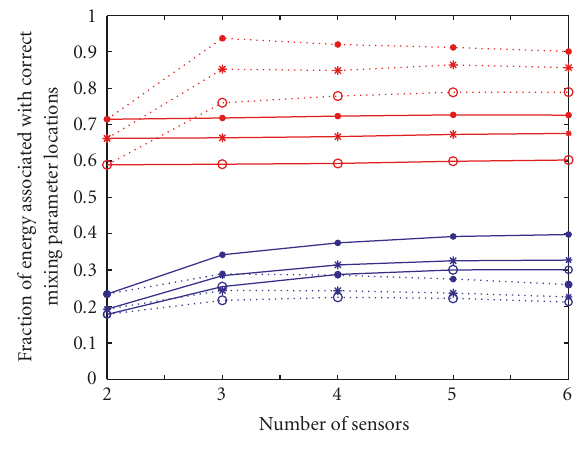
Figure 6: Comparison of the fraction of total histogram energy associated with correct mixing parameter locations for hard DE- SPRIT (solid) and soft DESPRIT (dotted) when 2( · ), 3( ∗ ), and 4 (o) sources are present and for signal-to-noise levels ∞ dB (red) and 0 dB